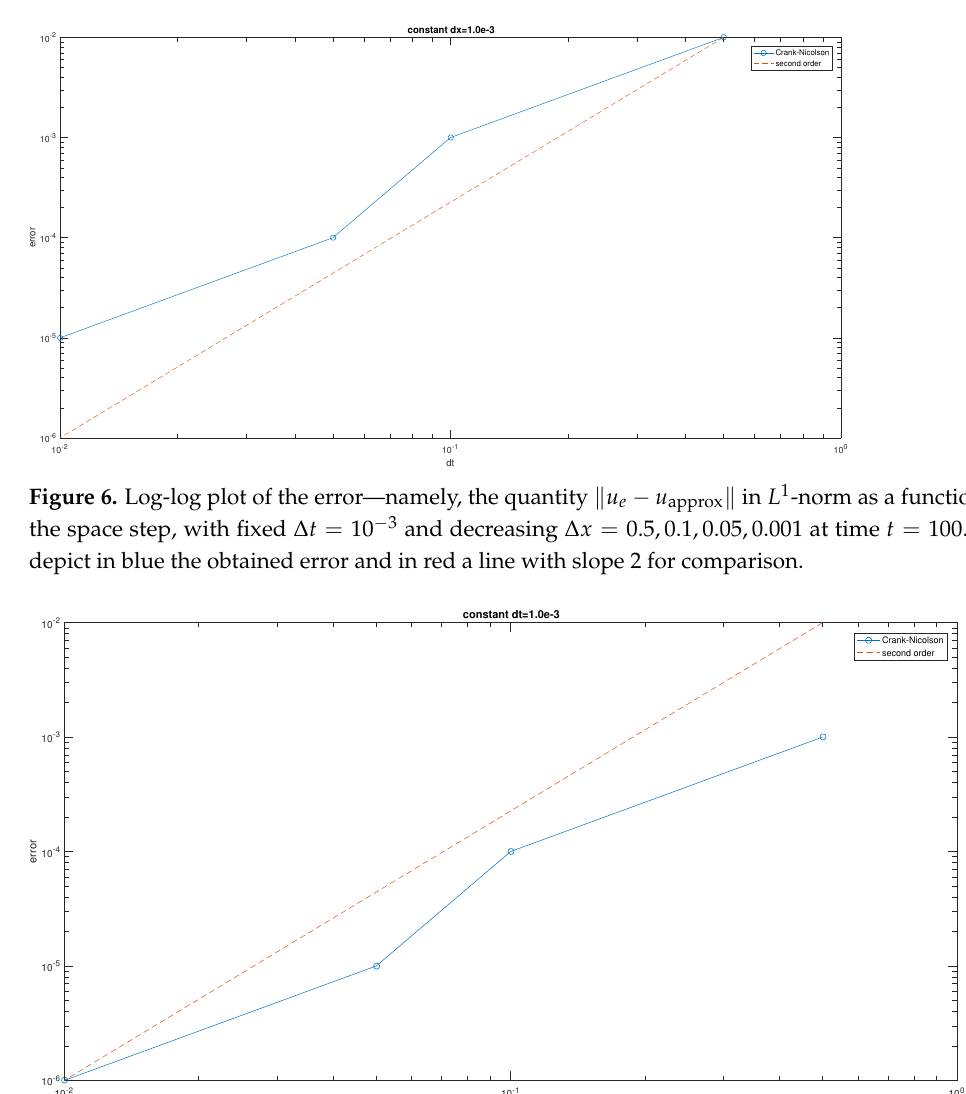
Figure 7. Log-log plot of the error, namely the quantity time step, with fixed ∆ x = 10 − 3 and decreasing ∆ t = 0.5,0.1,0.05,0.001 at time t = 100. We depict in blue the obtained error and in red a line with slope 2 for